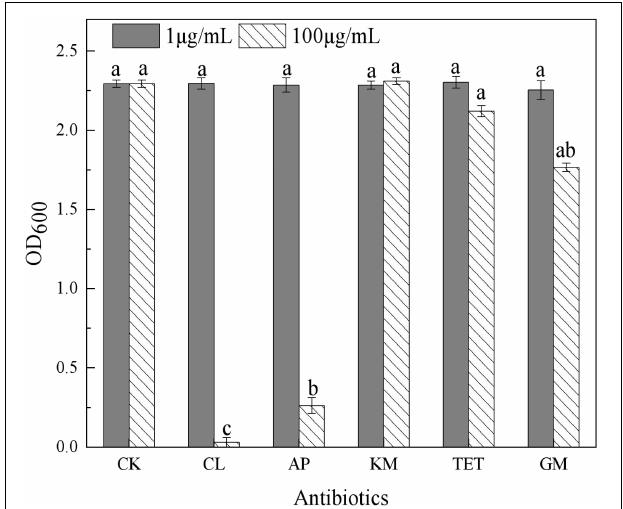
FIGURE 3 | Influence of antibiotics on Proteus mirabilis QZB-2 growth in 24 h (CK: no antibiotics; CL: chloramphenicol; AP: ampicillin; KM: kanamycin; TET: 2.212e; GM: gentamycin). Different letters indicate sinificant differences between treatments at P < 0.05.